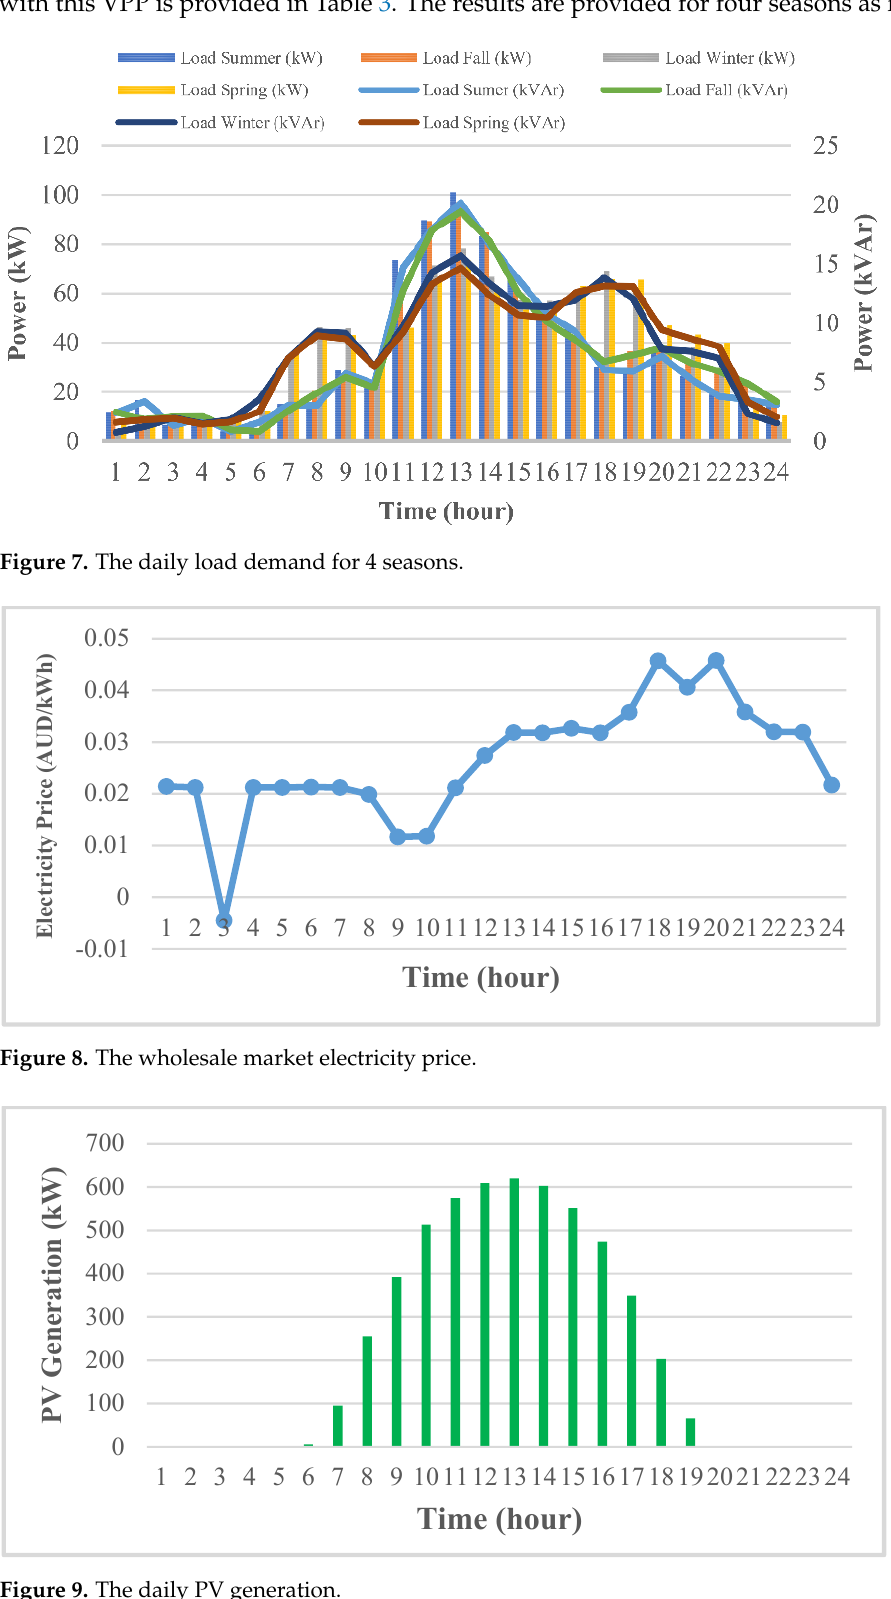
Table 3. Description of the single bus grid-forming VPP.